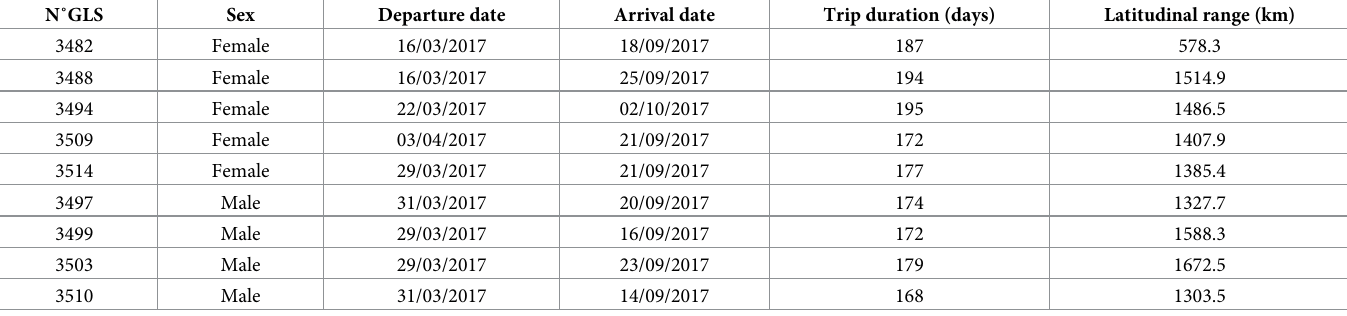
Table 1. Summary of details from Magellanic penguins equipped with geolocators at Martillo Island: Dates of departure and arrivals to the colony, and trip dura- tions (days). Also, for each penguin, latitudinal range (km) during the winter period is shown, estimated as the distance between the northernmost and southernmost location